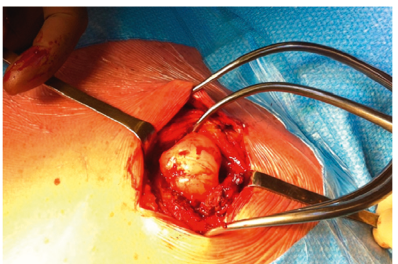
Figure 4: Surgical view of the osteochondroma. The lesion mea- sured 3cm T × 3cm AP × 2cm CC.